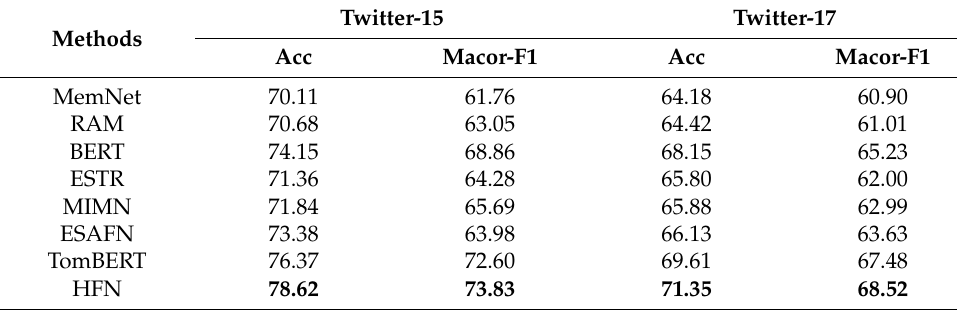
Table 7. Performance comparison over Twitter-15 and Twitter-17.